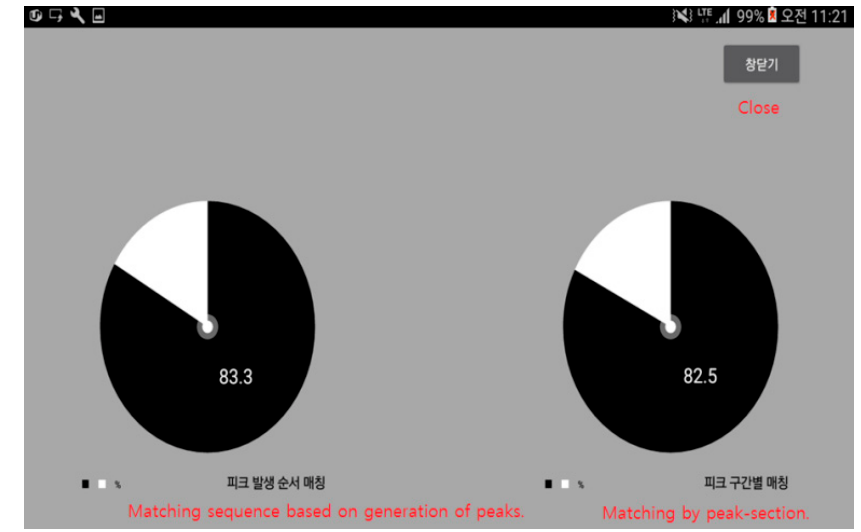
Figure 11. Result of segmental matching.